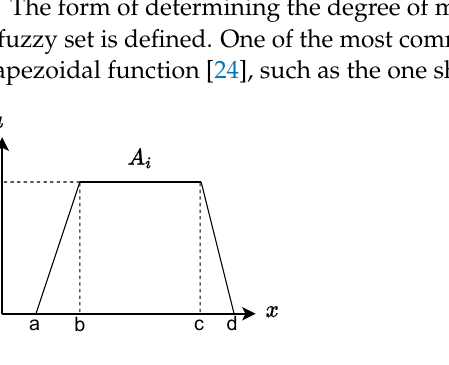
Figure 2. Trapezoidal membership function. This function is defined by four points and will have a value of 0 < u i ≤ 1 for a < x < d